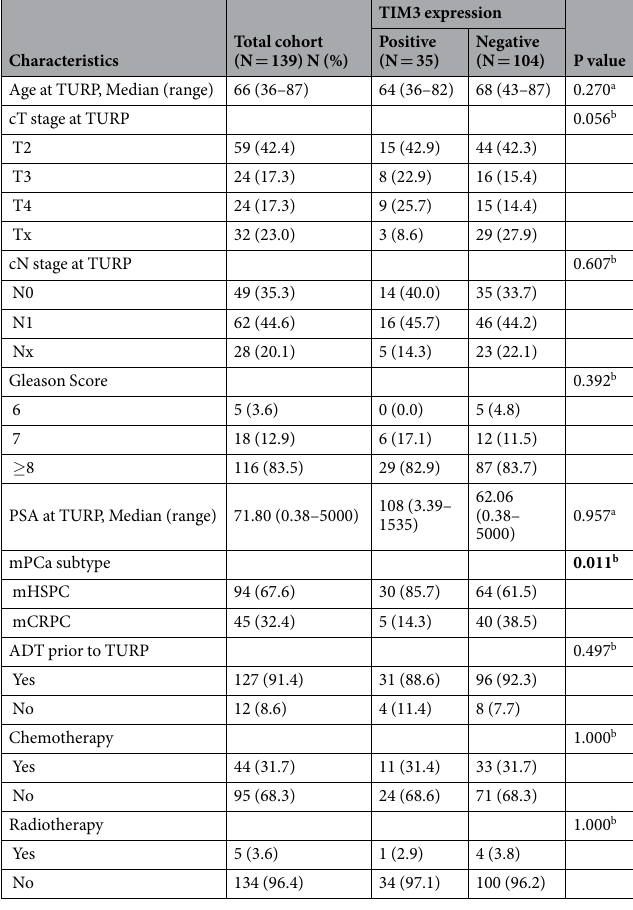
Table 1. Patient demographic and clinical characteristics. a Student’s t test. b Fisher exact test (based on Chi- square). TURP: transurethral resection of the prostate. ADT: androgen-deprived